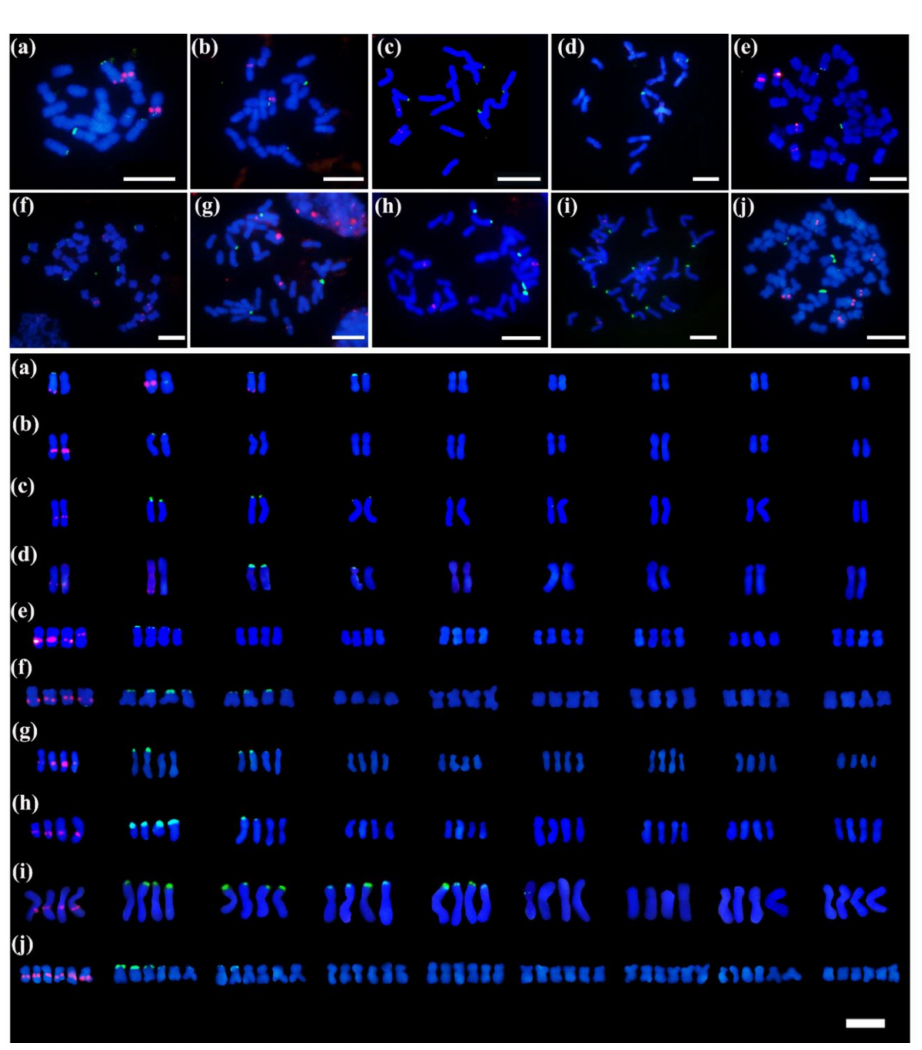
Figure 3. Distribution of 5S (red) and 45S (green) rDNA sites detected by Oligo-FISH: ( a ) Chrysan- themum indicum (Wuhan, Hubei) (NAU031); ( b ) C. lavandulifolium var. aromaticum (NAU010); ( c ) C. indicum (Botanical Garden, Beijing) (NAU077); ( d ) C. mongolicum (NAU011); ( e ) C. indicum (Lushan, Jiangxi) (NAU033); ( f ) C. indicum (Tianzhushan, Shaanxi) (NAU047); ( g ) C. indicum (Nan- chang, Jiangxi) (NAU032); ( h ) C. indicum (Taibaishan, Shaanxi) (NAU079); ( i ) C. nankingense (NAU172); ( j ) C. naktongense (NAU015). Scale bars, 10 µ